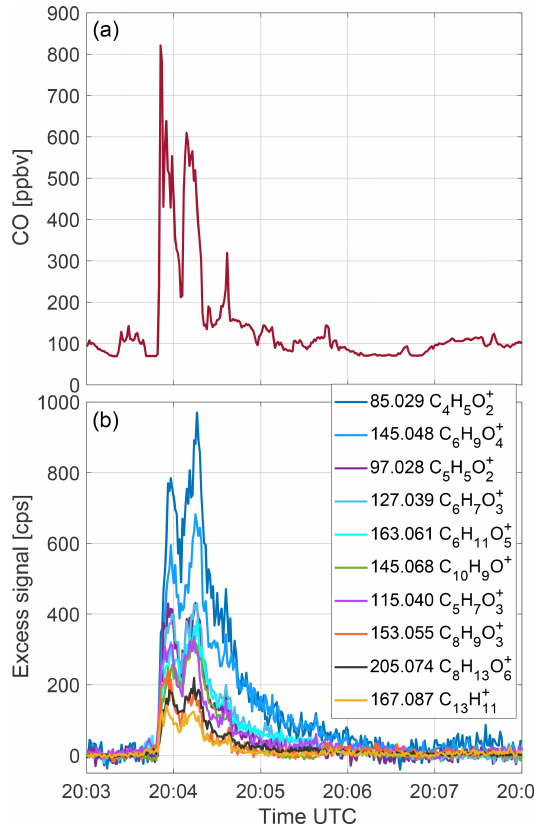
Figure 1. The 1Hz time series of the (a) carbon monoxide (CO) mixing ratio and the (b) excess signal (in raw counts per seconds; 90s pre-plume signal average subtracted) of the 10 ions ( m/z , sum formula) with the highest mass loadings as recorded by the airborne CHARON PTR-ToF-MS instrument during a wildfire plume pene- tration over the Sierra Nevada in